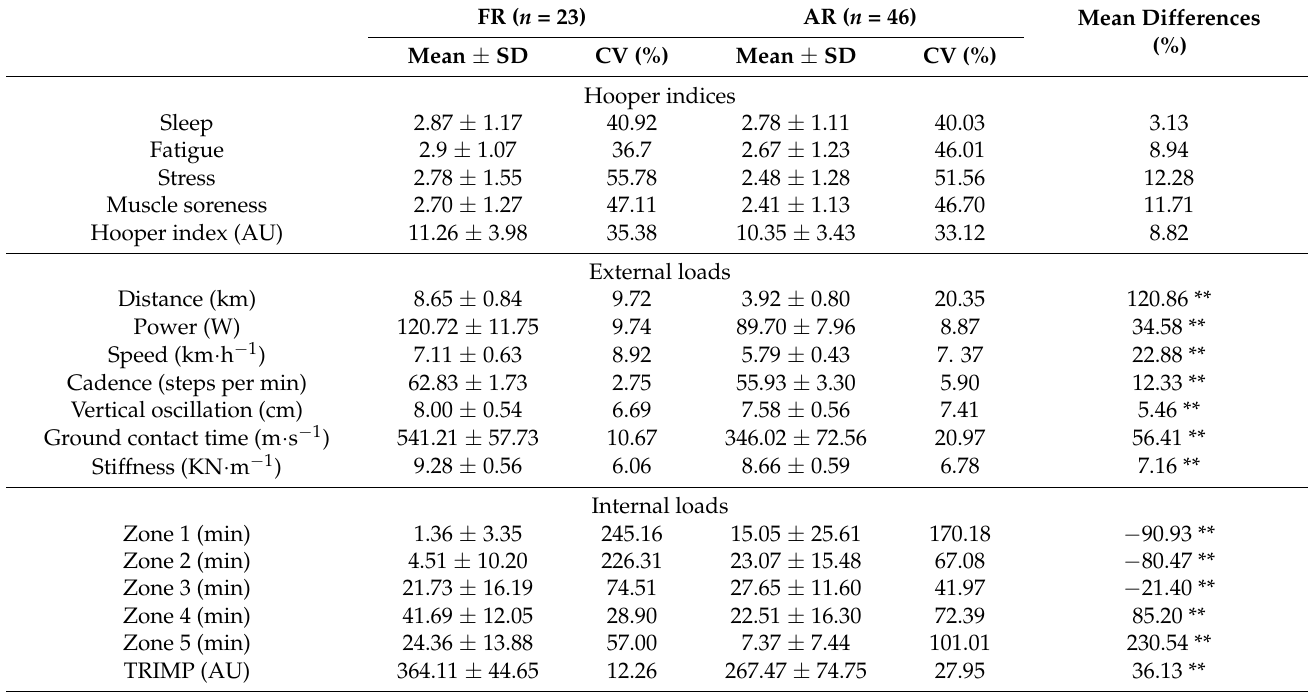
Table 1. Differences in Hooper indices, external and internal match loads between field referees (FR) and assistant referees